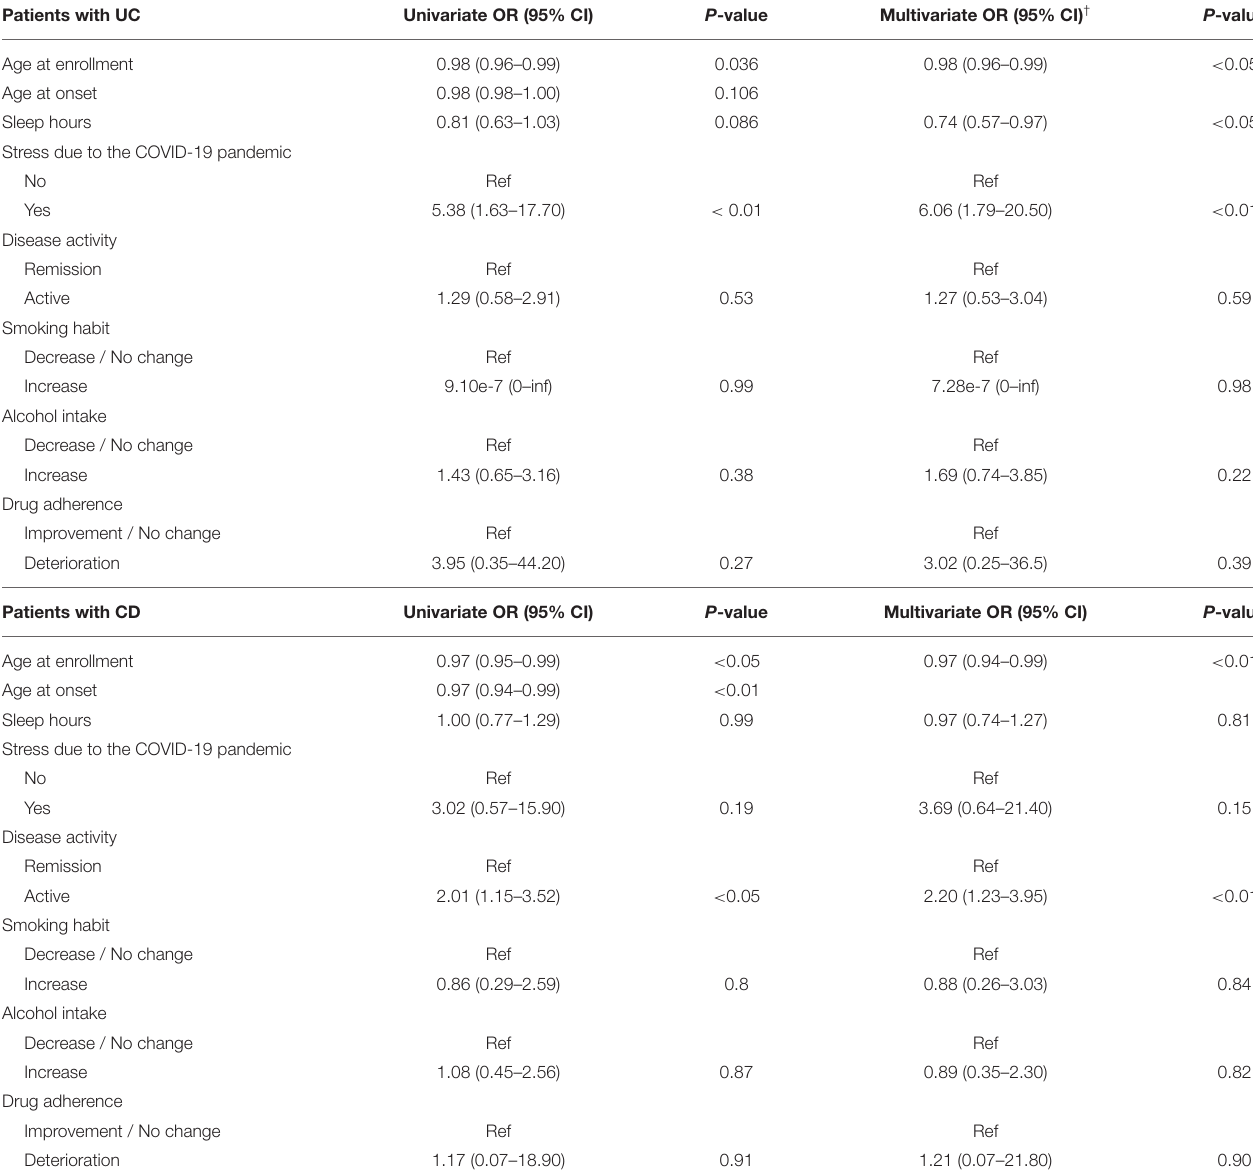
TABLE 3 | Logistic regression analyses of factors associated with exacerbation. Patients with